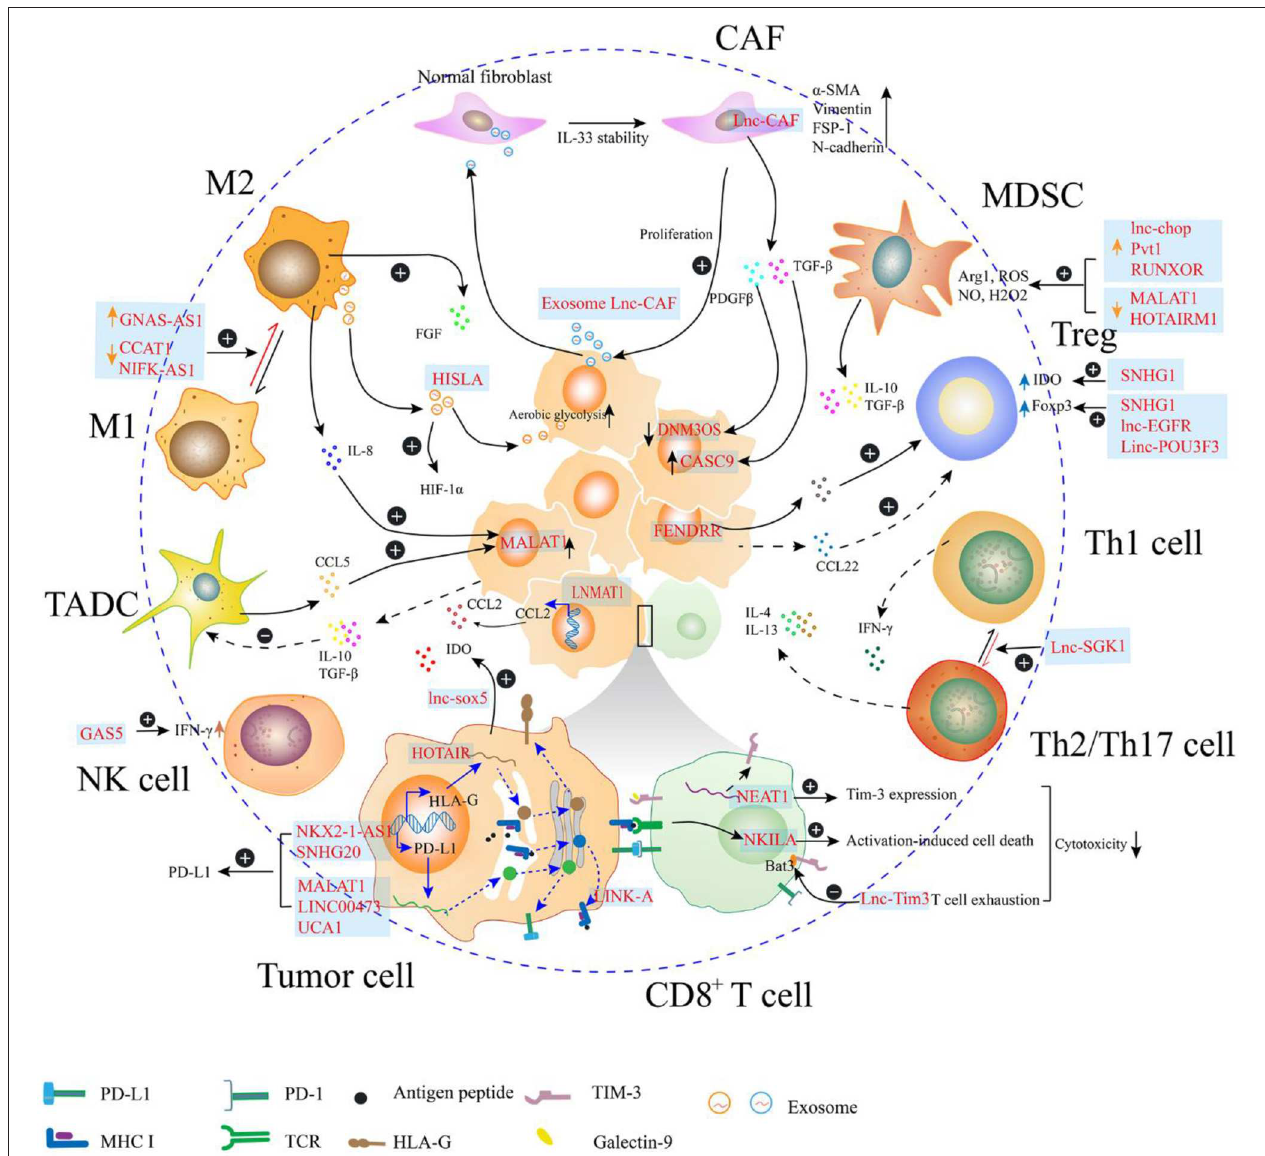
FIGURE 2 | Long non-coding RNAs (lncRNAs) regulate the immunosuppression in the tumor microenvironment (TME). In the TME, lncRNAs regulate the expression of molecules (e.g., PD-L1, MHC I, and HLA-G) on the surface of the tumor cells, which may attenuate the function of effector T cell. Additionally, the cytotoxicity of T cell can be directly regulated by lncRNAs within T cell, through mediating activation-induced cell death or enhancing T cell exhaustion. LncRNAs can also participate in the phenotype transition of cells, such as helper T cell, fibroblast, and macrophage, which can contribute to the formation of immunosuppressive TME. In the myeloid-derived suppressor cell (MDSC), lncRNAs enhance the production of immunosuppressive molecules, such as Arg1 and reactive oxygen species (ROS). Th1, type 1 helper T cell; Th2, type 2 helper T cell; Th17, T helper cell17; Treg, regulatory T cell; MDSC, myeloid-derived suppressor cells; CAF, cancer-related fibroblast; M1, M1 macrophage; M2, M2 macrophage; TADC, tumor-associated dendritic cell; NK cell, natural killer